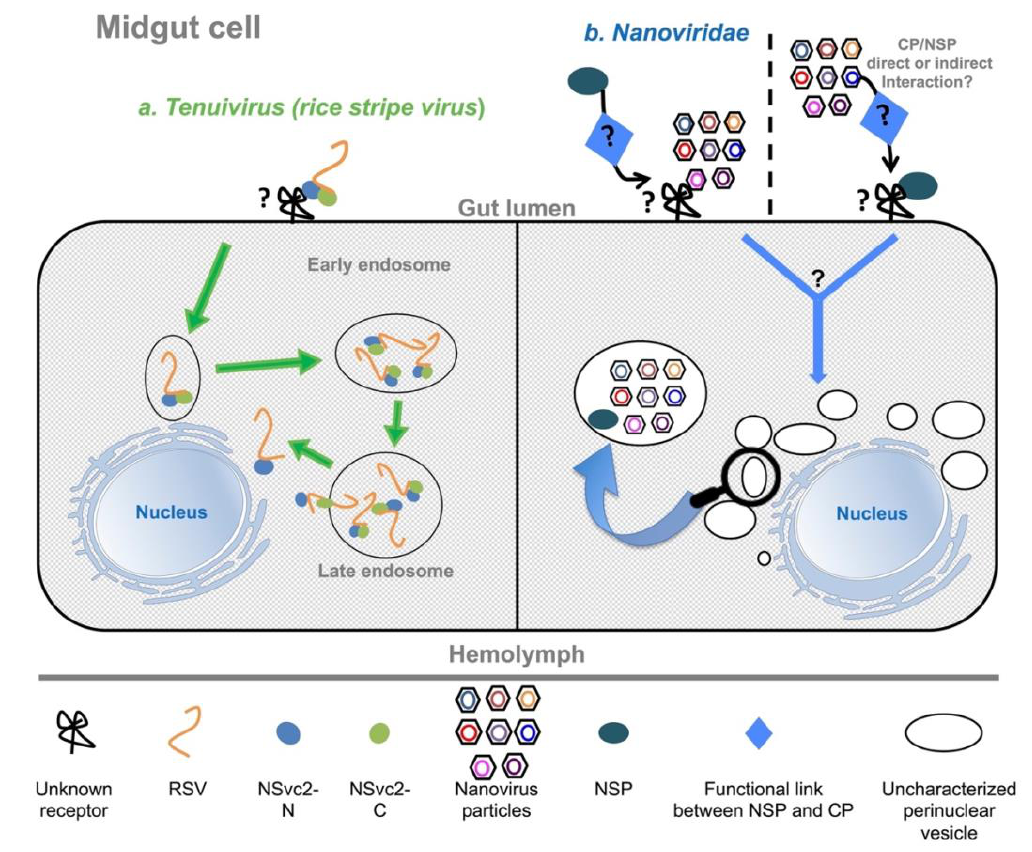
Figure 2 - Schematization of the hypothetical mode of action of HC for circulative viruses transmitted by hemipteran insects. The mode of action of HC in circulative propagative transmission of tenuiviruses is summarized on the left. The mode of action of the HC of circulative non propagative nanoviruses is shown on the right. There is a clear lack of molecular details that are currently awaiting further